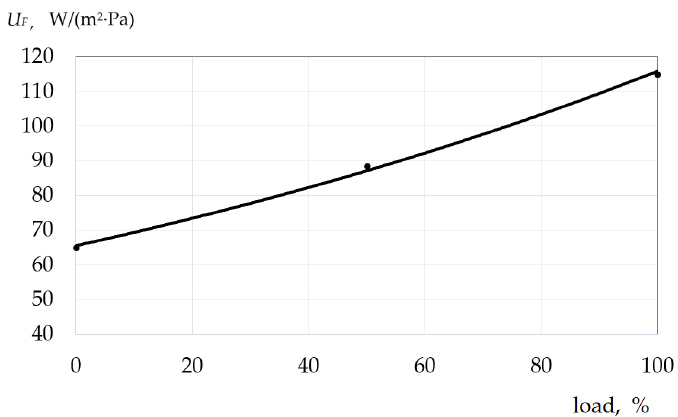
Figure 10. Dependence of combustion chamber forcing on the load value.